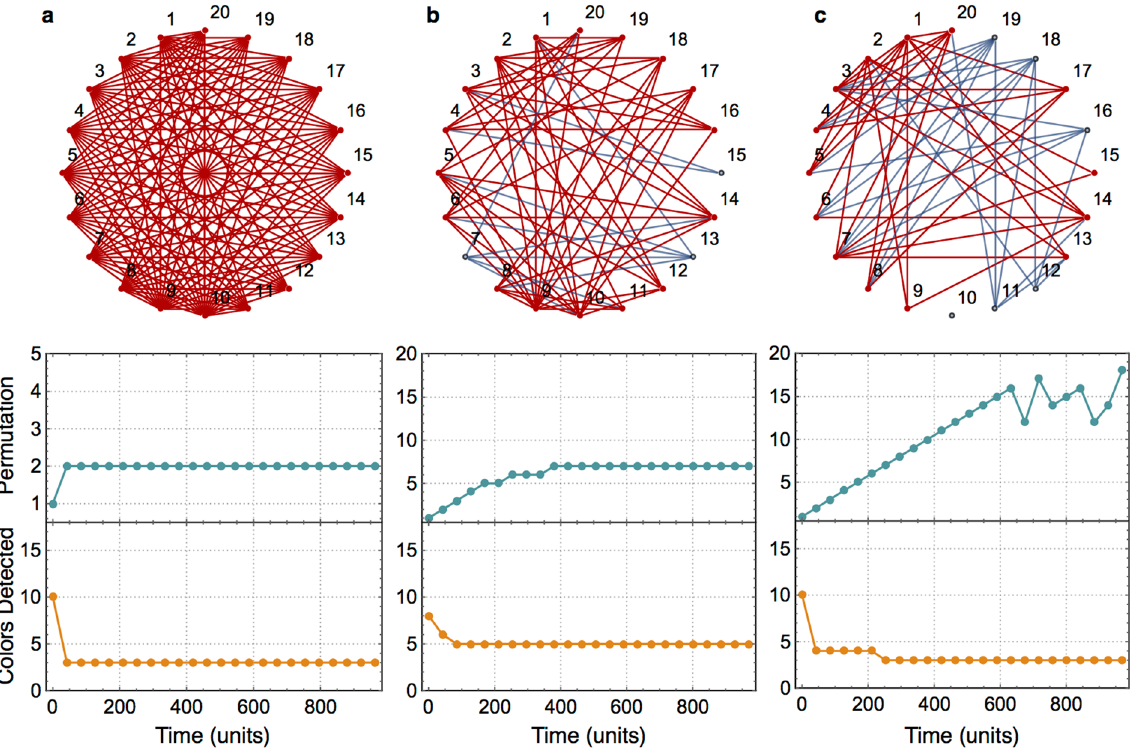
Figure 6. Effect of hardness on circuit behavior. (Above) Graph diagram and (below) waveforms of permutation number (a unique number corresponding to each permutation) of charging spikes and number of colors detected with time. All graphs are 3-partite with partition (8,2,10) with varying levels of average connectivity: ( a ) 1.0, ( b ) 0.57 and ( c ) 0.48. All triangles in the graph are shown with red edges and the rest edges are shown in